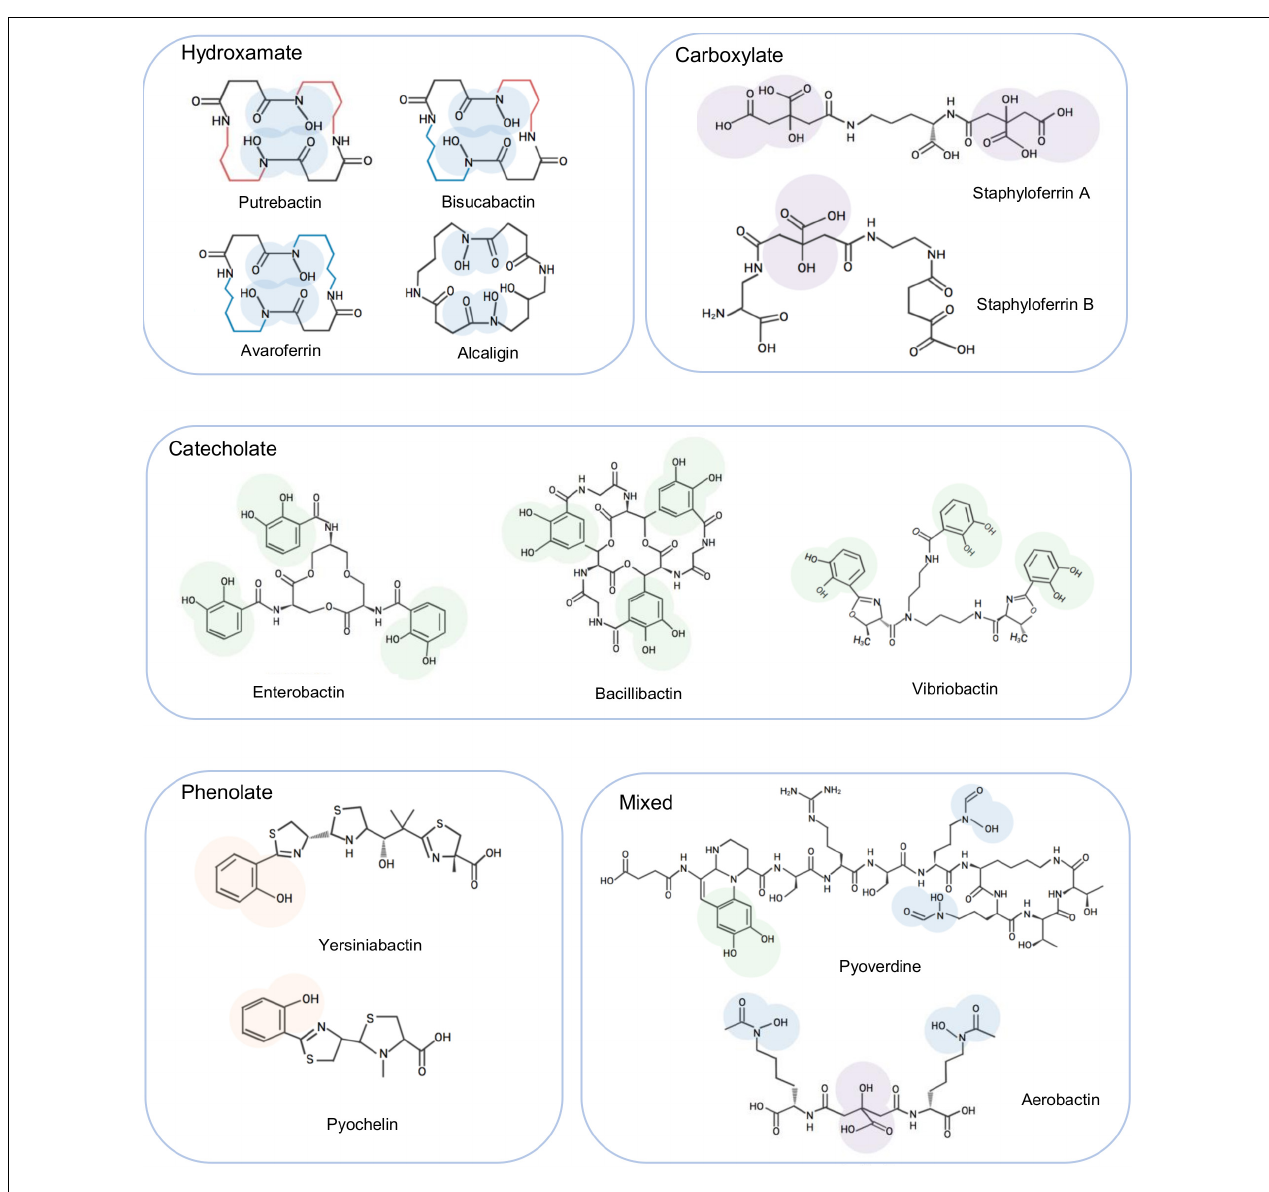
FIGURE 1 | Representative siderophores synthesized by bacteria. To show the characteristics of each type, the iron binding moieties of these siderophores are highlighted. These siderophores are also mentioned in the text as examples to facilitate illustration of siderophore biosynthesis and transport.